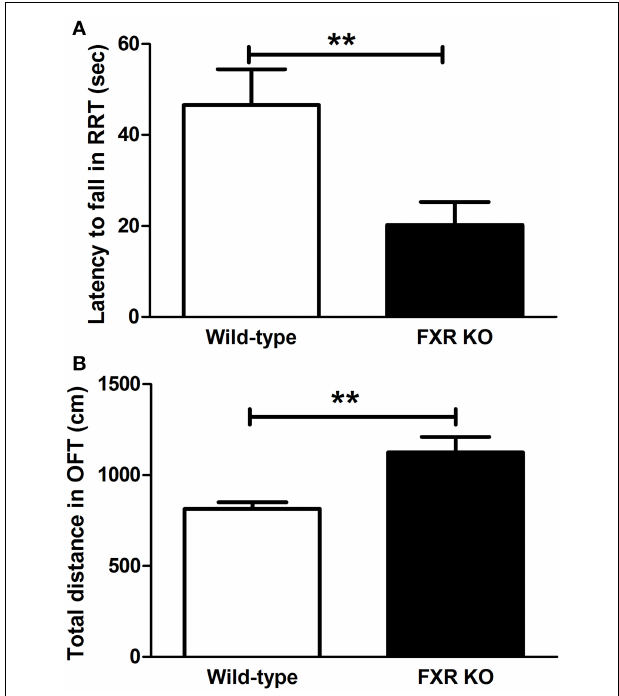
FIGURE 5 | FXR KO altered motor performance of the mice. In comparison with wild-type controls, FXR KO mice fell from the rod more often in the RRT (A) but seemed to be hyperactive in the OFT (B) . N = 12 /group; ** p < 0 . 01 .